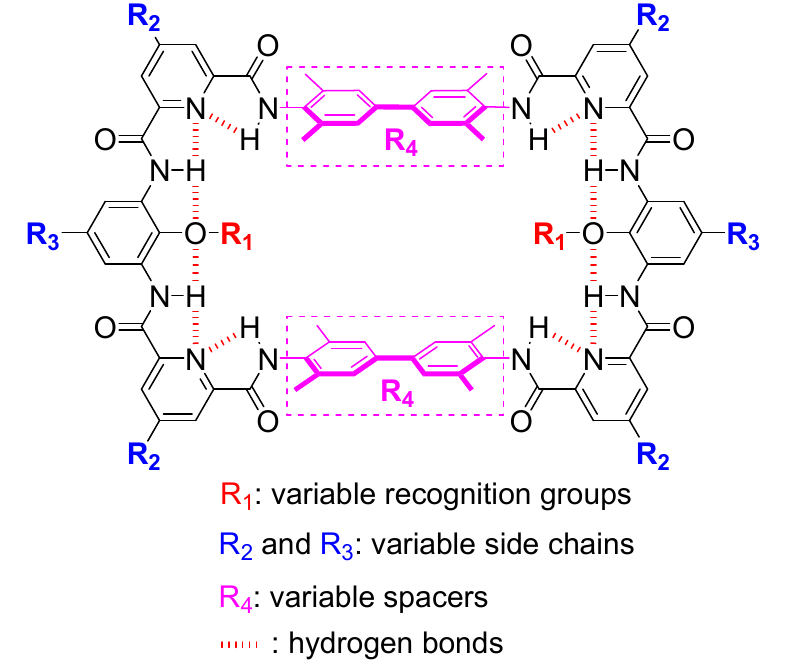
Figure 1. Molecular design. Tethers (aromatic oligoamide sections) are shown in black and spacers (biphenyl sections) are shown in plum.